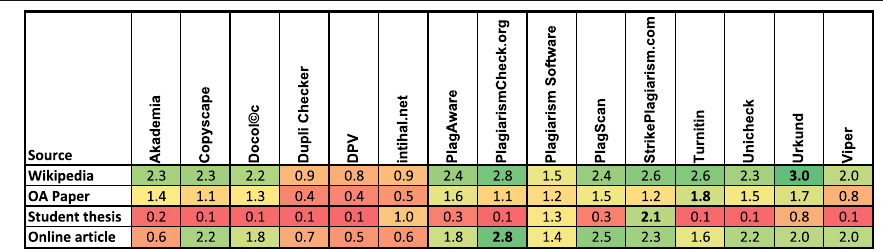
Table 4 Coverage results according to the type of source